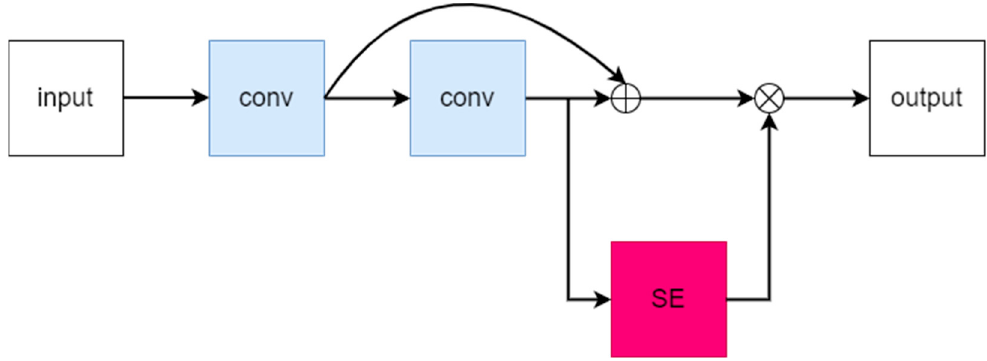
Figure 4. Architecture of proposed RCA block.